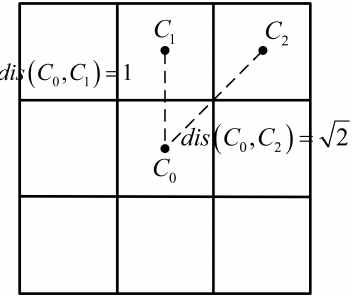
Figure 6. Neighborhood grids.